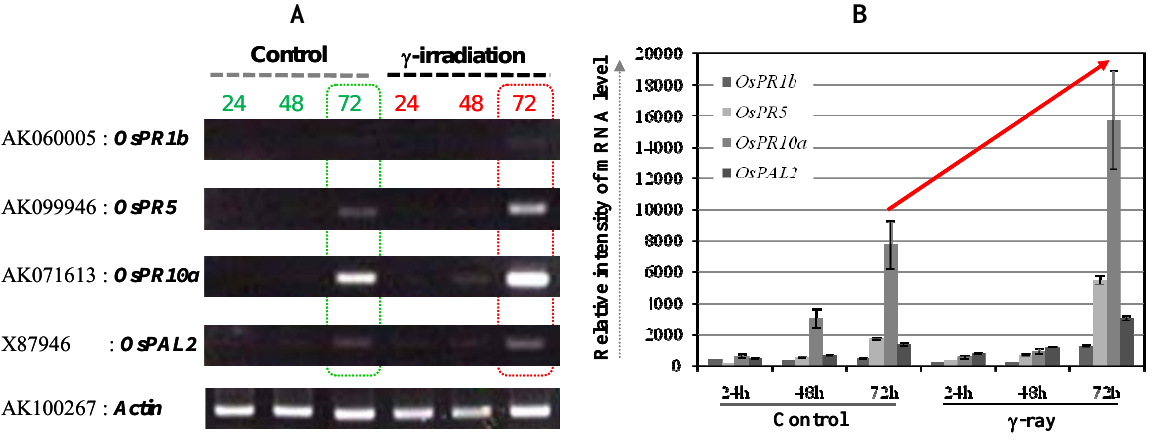
Figure 3. Ultra low-dose  -irradiation induces strong expression of the PR-related defense/stress markers. The dummy (Control, dose rate of 5  Gy/3 day) and irradiated (dose rate of 110  Gy/3 day) samples were prepared for total RNA extraction and RT-PCR (A) as described in sections 2.3 and 2.4. In A, dotted boxed rectangles in green and red highlight the differential gene expression levels between control and treatment. On the right-hand side, the relative intensity of mRNA level of each gene is presented (B). The upward pointing red arrow shows the drastic change in rice marker gene expressions upon treatment, in particular the distinct increase in expression of the OsPR10a gene